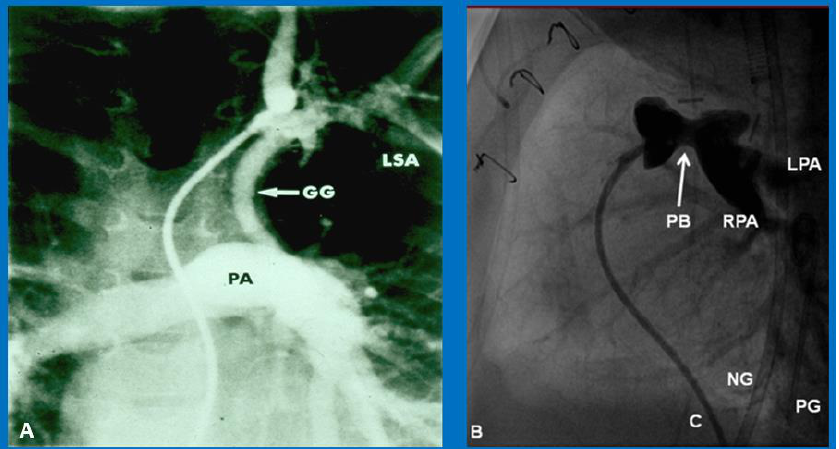
Figure 9. ( A ) . Selected cine-angiographic frame showing modified Blalock-Taussig (BT) shunt con- necting left subclavian artery (LSA) with the pulmonary artery (PA) with a Gore-Tex grafts (GG) [30]. This cine frame shows wide-open BT shunt and excellent opacification of PA. ( B ). Selected cine frame form PA cine-angiogram in straight lateral projection demonstrating narrowed section of the PA produced by pulmonary artery band (PB) shown by arrow in ( B ) in an infant who had the PB [37]. C, catheter; LPA, left pulmonary artery; NG, nasogastric tube; PG, pigtail catheter; RPA, right pulmonary artery. Modified from